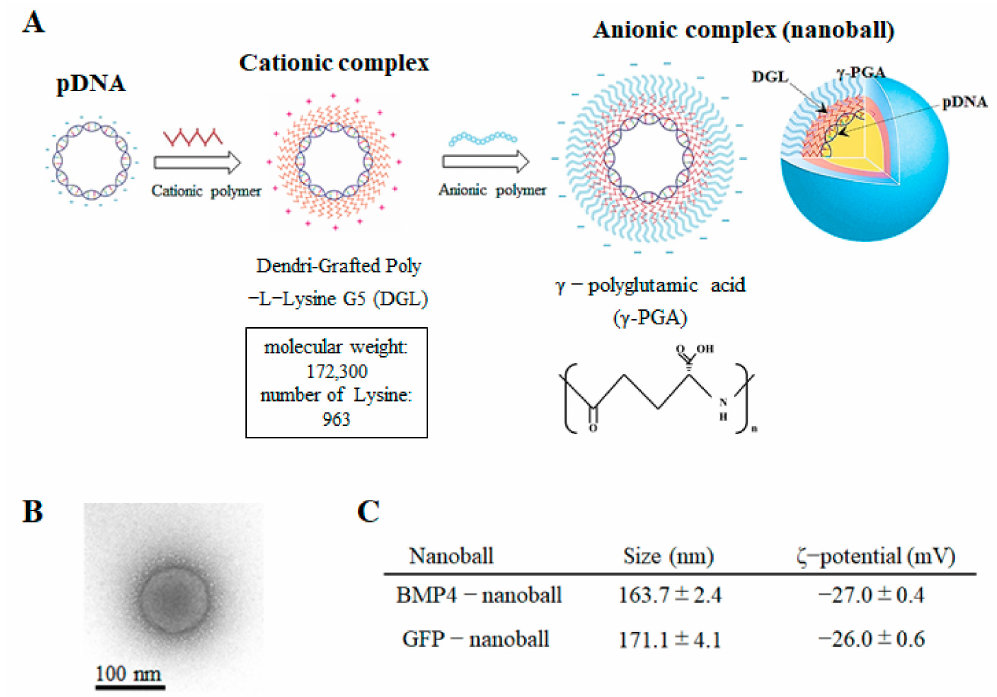
Figure 1. Characterization of nanoballs. ( A ) Schematic diagram presents the synthesis of nanoballs. ( B ) TEM image of a nanoball (BMP4-nanoball). There are no obvious differences between the TEM images of GFP- and BMP4-nanoballs. ( C ) Physicochemical properties of nanoballs. The data represent the mean ± SD ( n =